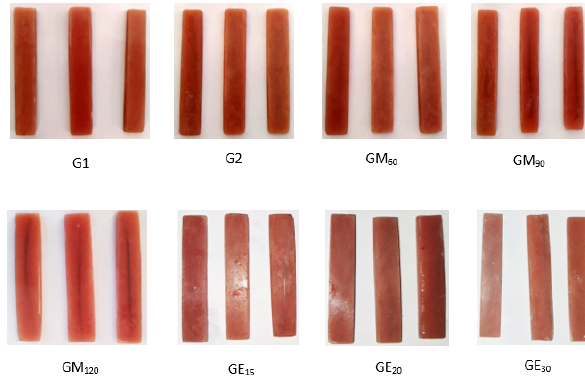
Figure 1: Reinforced PMMA Samples: G1) reference samples,